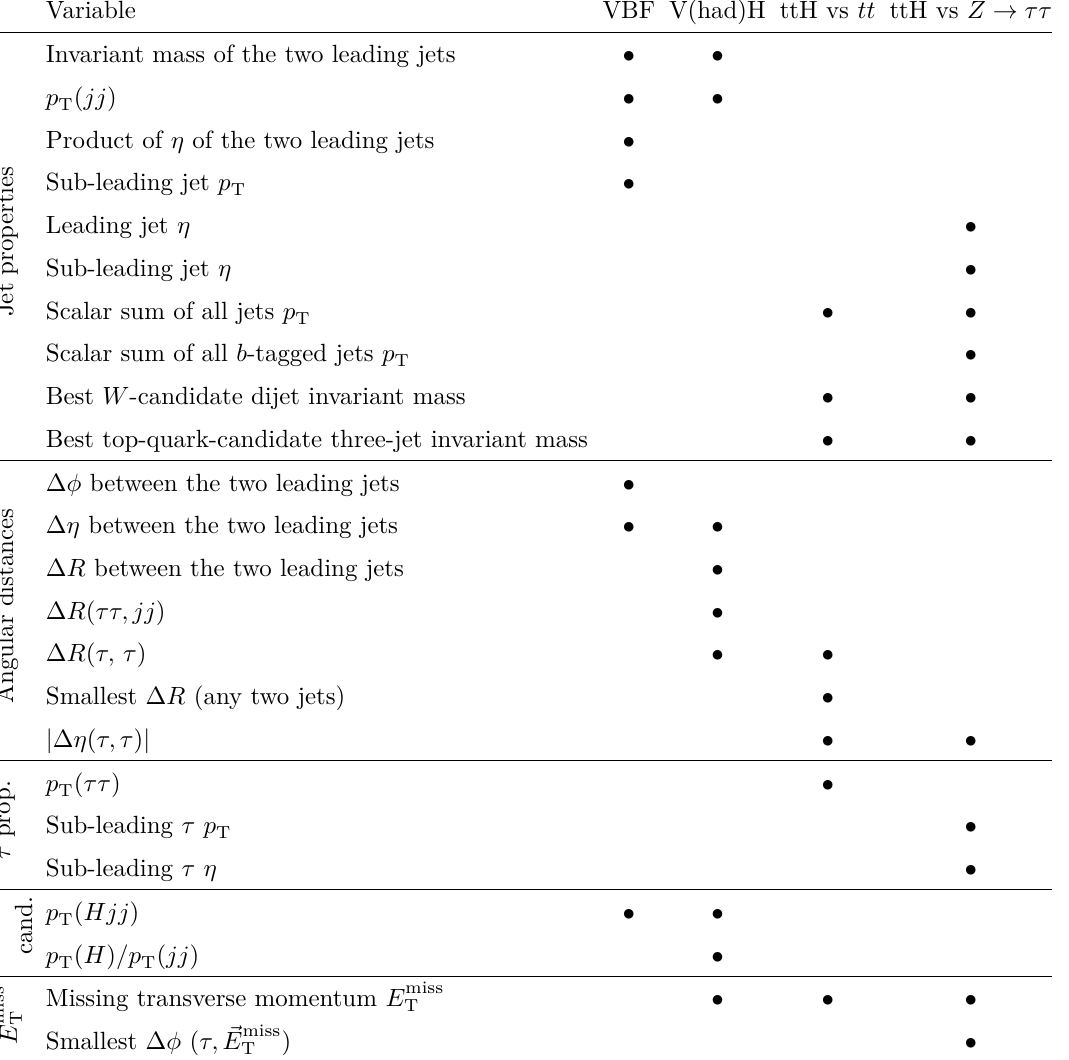
• ) as appropriate in each channel. had-vis . The W candidate is built as the pair of T . The top-quark candidate is built W top